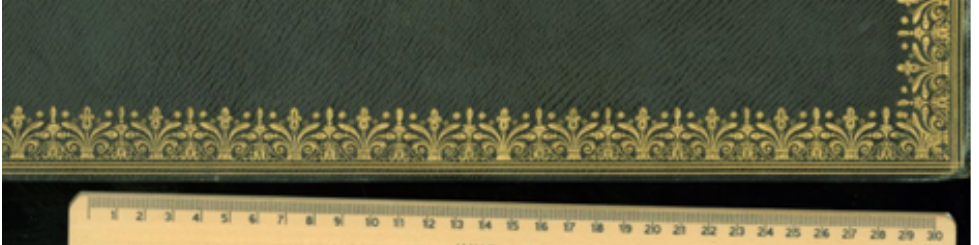
Fig. 46. Gold-tooled frame on tail edge of upper cover of the binding on Henry Winstanley, The Royal Palace of Audley End [Littlebury, 1688]. Signed by John Mackenzie. BL,